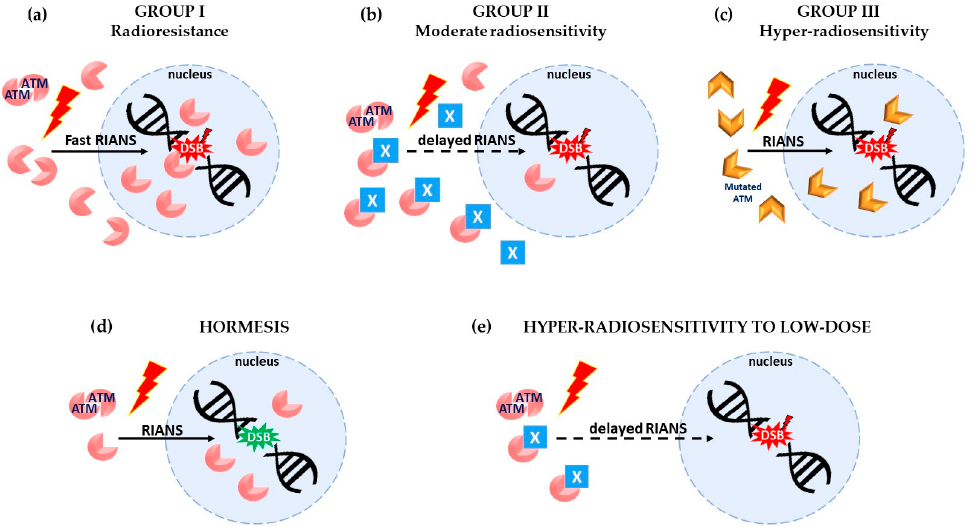
Figure 1. High- and low-dose radiation cell response explained by the RIANS model. The RIANS underpins the efficiency of DSB recognition and repair and the cellular radiosensitivity. At high doses, ( a ) a fast RIANS ensures radioresistance ( group I ) with complete recognition and repair of radiation-induced DSB (red star), ( b ) a RIANS delayed by the interaction of ATM with X-proteins (blue squares) leads to moderate radiosensitivity ( group II ), and ( c ) mutated ATM kinase leads to the lack of DSB recognition, which causes hyper-radiosensitivity ( group III ). It is noteworthy that group III hyper-radiosensitivity can also be caused by gross DSB repair, such as in the case of LIG4 mutation. However, this particular case is not illustrated here. ( d ) Hormesis effect. At very low-dose (< 25 mGy), some ATM monomers can contribute to the recognition and repair of spontaneous DSB (green star), the amount of radiation-induced DSB being negligible. The hormesis effect is preferen- tially observed in group I cells. ( e ) Hypersensitivity to low dose (HRS). At low doses (ideally be- tween 0.1 and 0.5 Gy), the flux of ATM monomers can be reduced again by the interactions with X- proteins (in group II cells). A too-low amount of ATM monomers that diffuse in the nucleus does not permit the recognition of the few DSB induced by radiation (red): the HRS phenomenon is pref- erentially observed in group II cells. It is noteworthy that the hyper-radiosensitivity observed at high doses in group III cells should not be confused with the hyper-radiosensitivity to low-dose